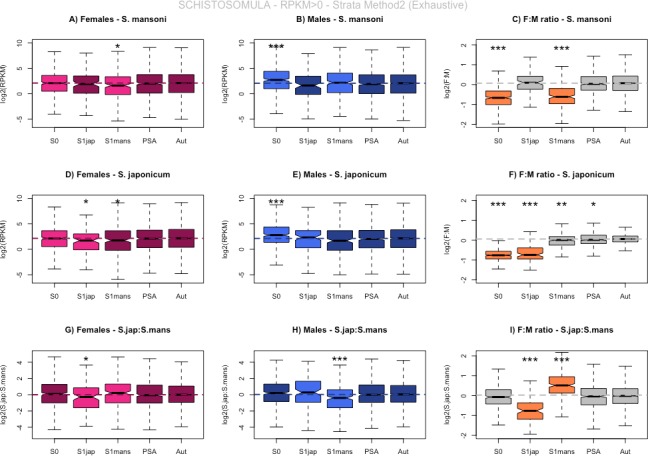
Schistosomula expression patterns (RPKM>0, exhaustive strata) of genes located in the different strata of the Z (S0, S1man and S1jap), as well as pseudoautosomal and autosomal genes.The distribution of expression values is shown for (A) S. mansoni females, (B) S. mansoni males, (C) S. mansoni female:male, (D) S. japonicum females, (E) S. japonicum males, (F) S. japonicum female:male, (G) Female expression in S. japonicum divided by female expression in S. mansoni, (H) Male expression in S. japonicum divided by male expression in S. mansoni, (I) female:male ratio of expression in S. japonicum divided by female:male ratio of expression in S. mansoni. Asterisks represent levels of significance of comparisons to the control autosomal genes (*p-value<0.05, **p-value<0.001, ***p-value<0.0001). Genes were assigned to each Z-chromosome stratum based only on their coverage patterns; only genes with RPKM >0 were used.